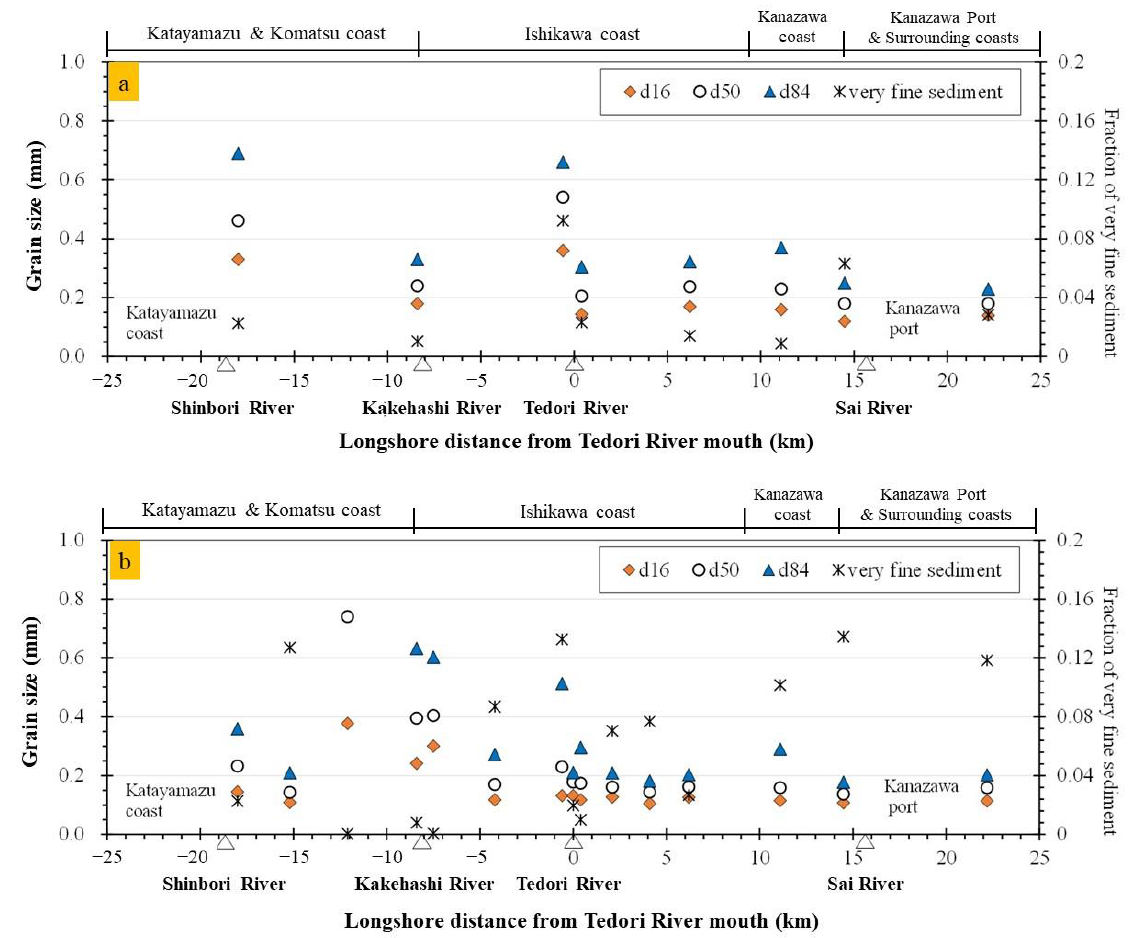
Figure 9. Longshore variations in the sediment grain size in the: ( a ) surf zone and ( b ) offshore zone, at depths of 5 m and 15 m.